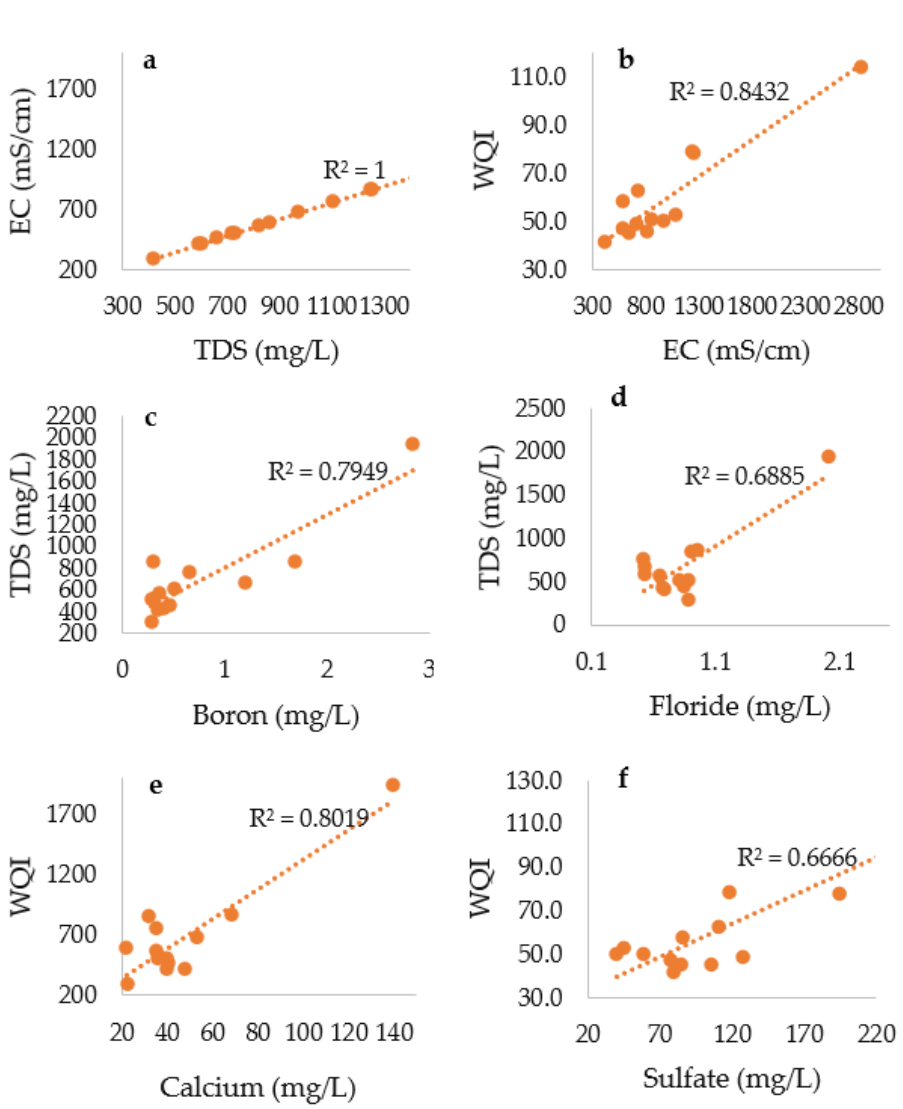
Figure 6. Correlation between some studied parameters of water samples: ( a ) correlation between EC and TDS; ( b ) between EC and WQI; ( c ) between TDS and Boron; ( d ) between TDS and Floride; ( e ) between WQI and Calcium and ( f ) correlation between WQI and Sulfate.